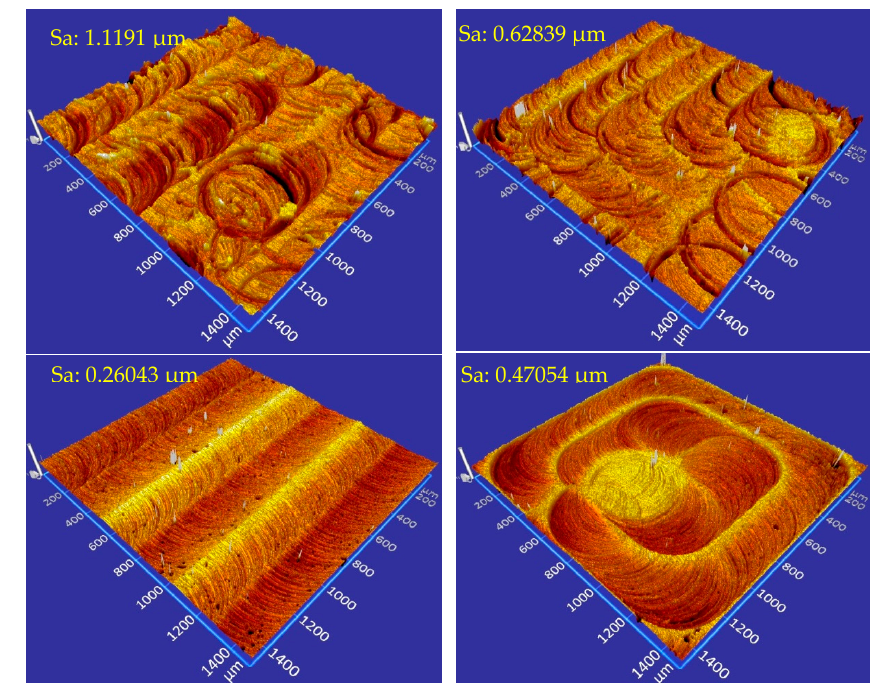
Figure 6. 3D surface topography measurements of the milled pocket.